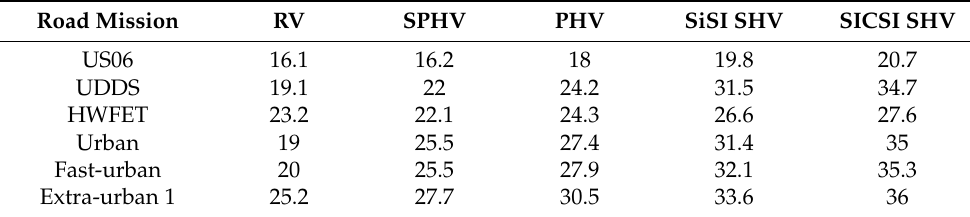
Table 12. Comparison among the fuel economy of different HEVs for various road missions (km/l). Road